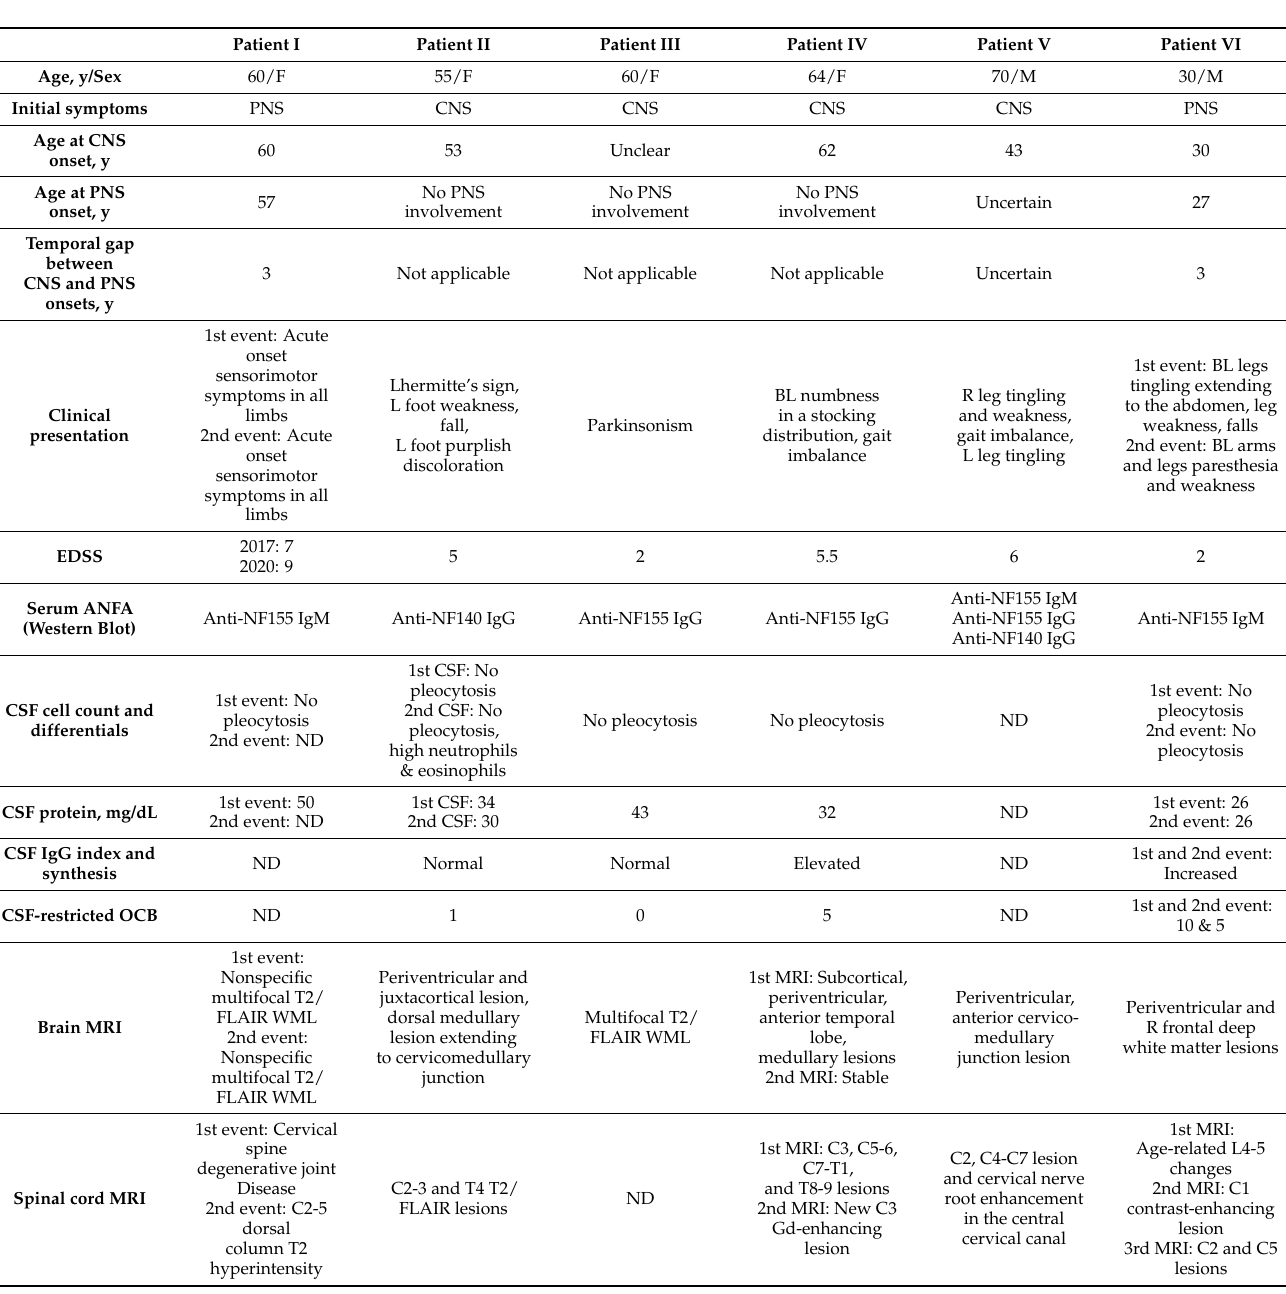
Table 2. Demographic data, clinical features, and diagnostic evaluation results for the six